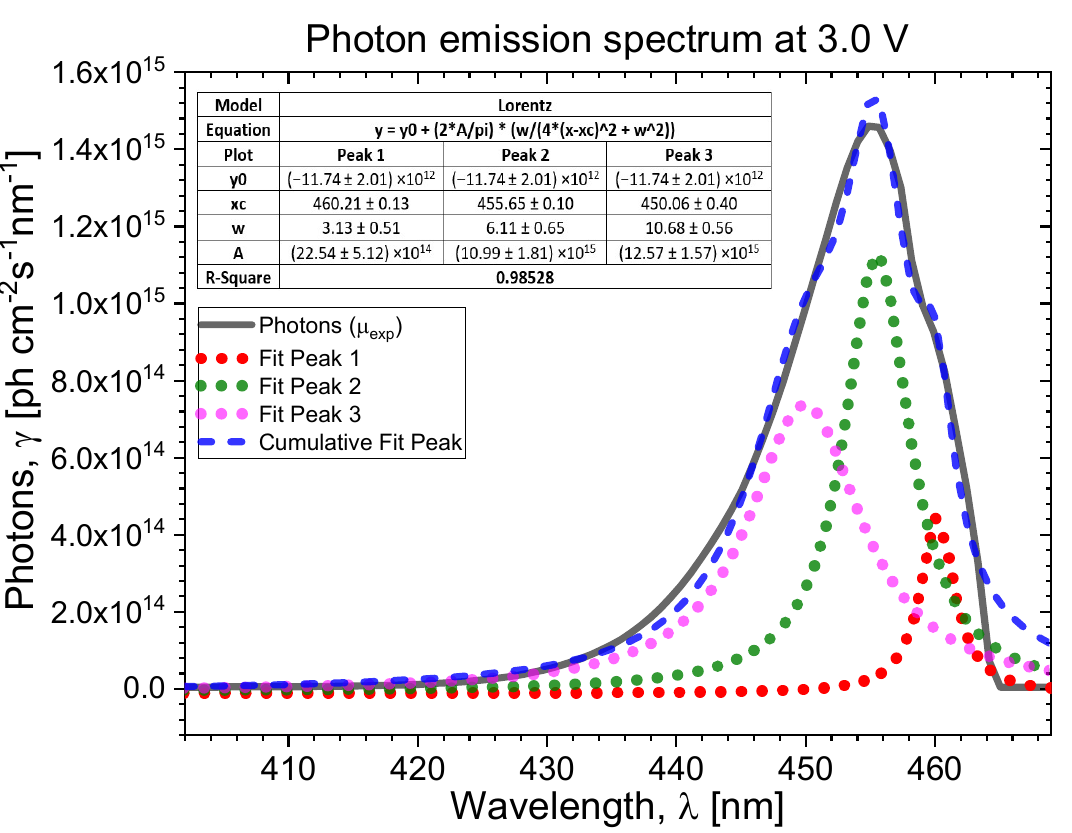
Figure 11. Deconvolution of the photon emission spectrum for the experimental simulation at 3.0 V. Peak photon emission at different mobilities Figure 12 shows the peak wavelength achieved for each mobility with respect to the supplied voltage (2.5–4.0) V, where it is confirmed the stable point of the emission corresponds to ˆ λ LED = 456.7 nm, since all simulations take the same wavelength value and the lowest FWHMs. Therefore, in this voltage range, the SRH and Auger recombination have very similar values, and the radiative recombination is maximized as it is explained in [10,11]. Experimental computation leads to varied values of the emission peak, making it less stable. Doping-concentration simulation has a lower violet shift of the emitted wavelength at higher voltages, which makes it more